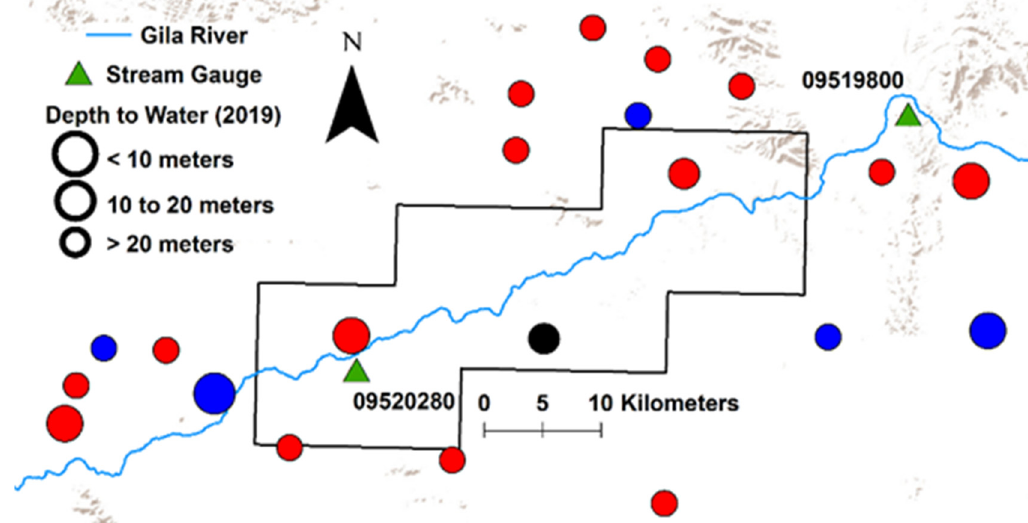
Figure 6. Location of wells and stream gauges in relation to the study area. There are 21 indexed wells, shown as circles, located in and around the study area. Larger circles represent wells with lower depth to water and smaller circles represent greater depth to water. Wells shown in red indicate wells where the depth to water has increased since 1992, while wells shown in blue indicate wells where the depth to water has decreased since 1992. The well displayed in black did not register a change in depth. USGS stream gauge locations are shown as green triangles. The Dateland gauge (09520280) is on the western side of the map and the Painted Dam gauge (09519800) is on the eastern side of the map. The study area shown in Figure 1 is represented by the black box.